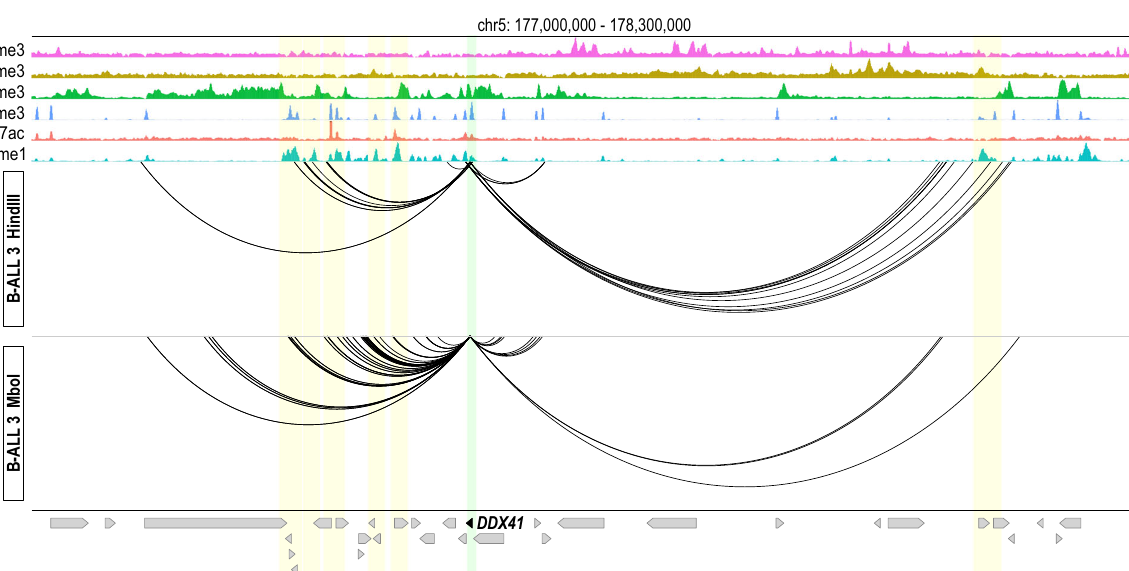
regions for liCHi-C libraries generated with MboI (blue) and HindIII (green) diges- tion, respectively. The median and highest absolute frequency of interactions are represented by solid and dashed lines, respectively. D DDX41 gene promoter- centered interaction landscape (arcs) generated with HindIII (top) and MboI (bot- tom), respectively. Green shade depicts the DDX41 gene promoter, while yellow shades depict putative enhancer regions for it. Arrows symbolize gene placement and orientation along the genomic